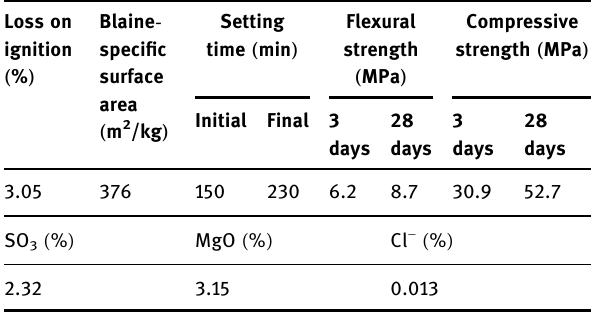
Table 1: Physical properties and chemical composition of cement Loss